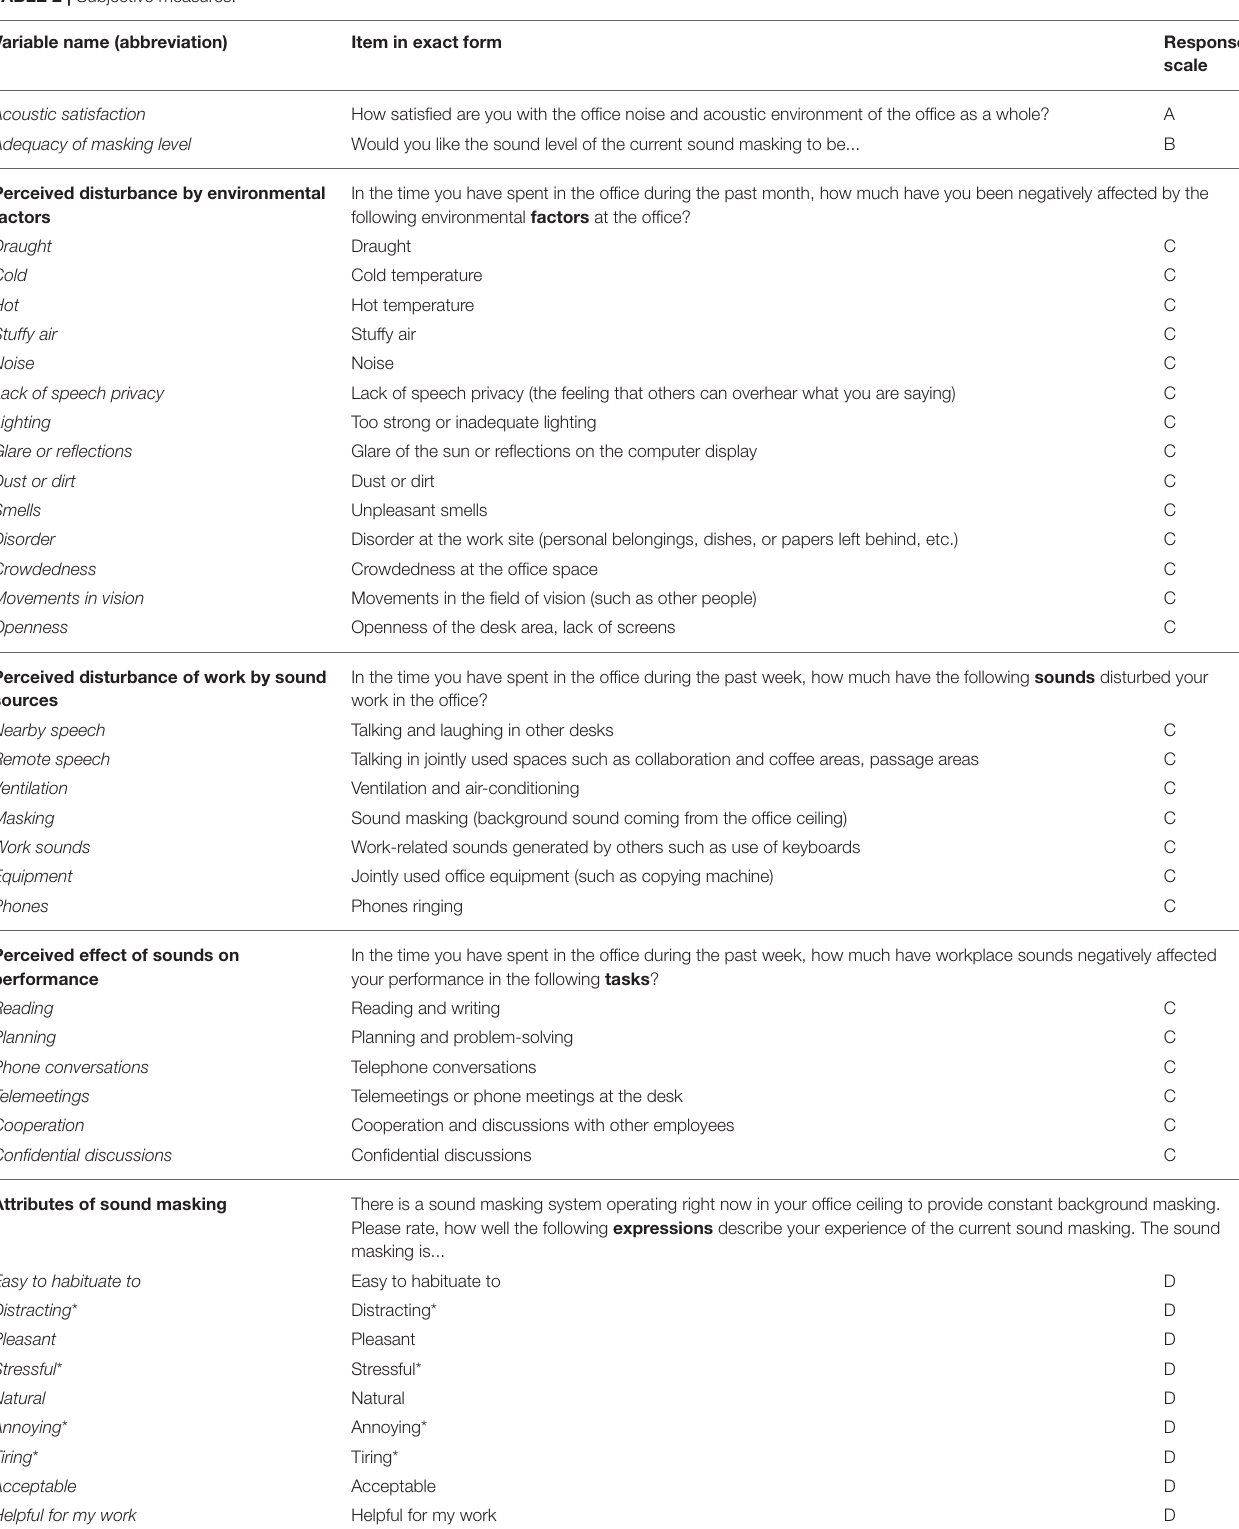
TABLE 2 | Subjective